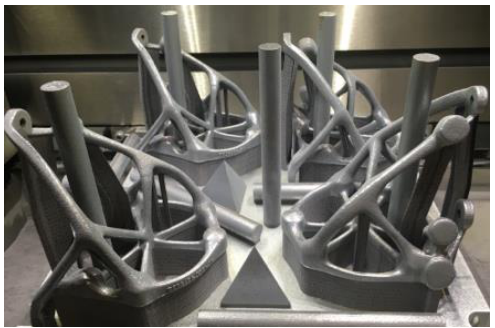
Figure 9. Build plate with 4star tracker camera bracket components.